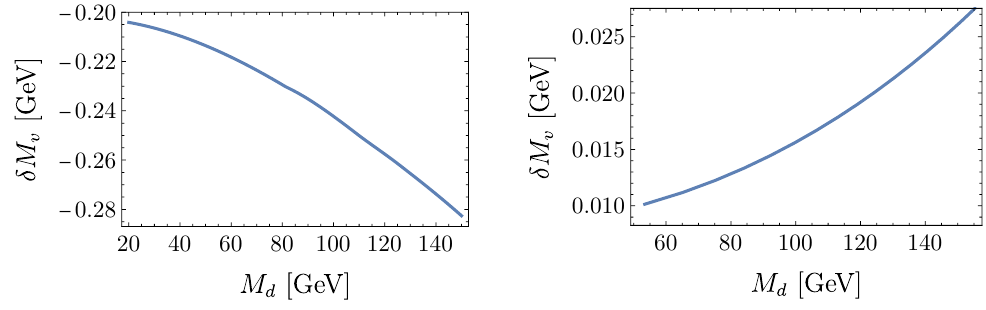
Figure 10 . Change of the mass δM v = M ( without ) v − M ( with ) v with and without a dark sector respectively in the case where the dark scalar does not undergo spontaneous symmetry breaking. The cosmological constant is Λ = − 10 ( Λ = − 6 . 52 ) in the left (right) panel, while the Newton ∗ ∗ coupling G is varied such that the Yukawa coupling is fixed at y = y = 0 . 37 . ∗ ∗